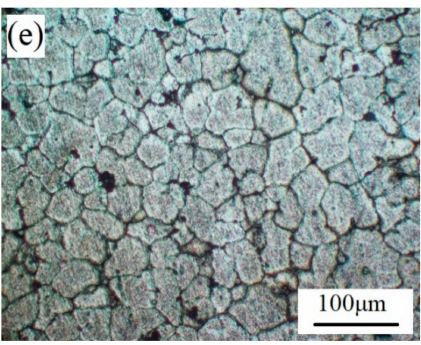
Figure 2. Optical photograph of the as-cast 7085 and TiC / 7085 alloys ( a ) 7085; ( b ) 0.1 wt% TiC / 7085; ( c ) 0.3 wt% TiC / 7085; ( d ) 0.5 wt% TiC / 7085; ( e ) 1 wt% TiC / 7085.